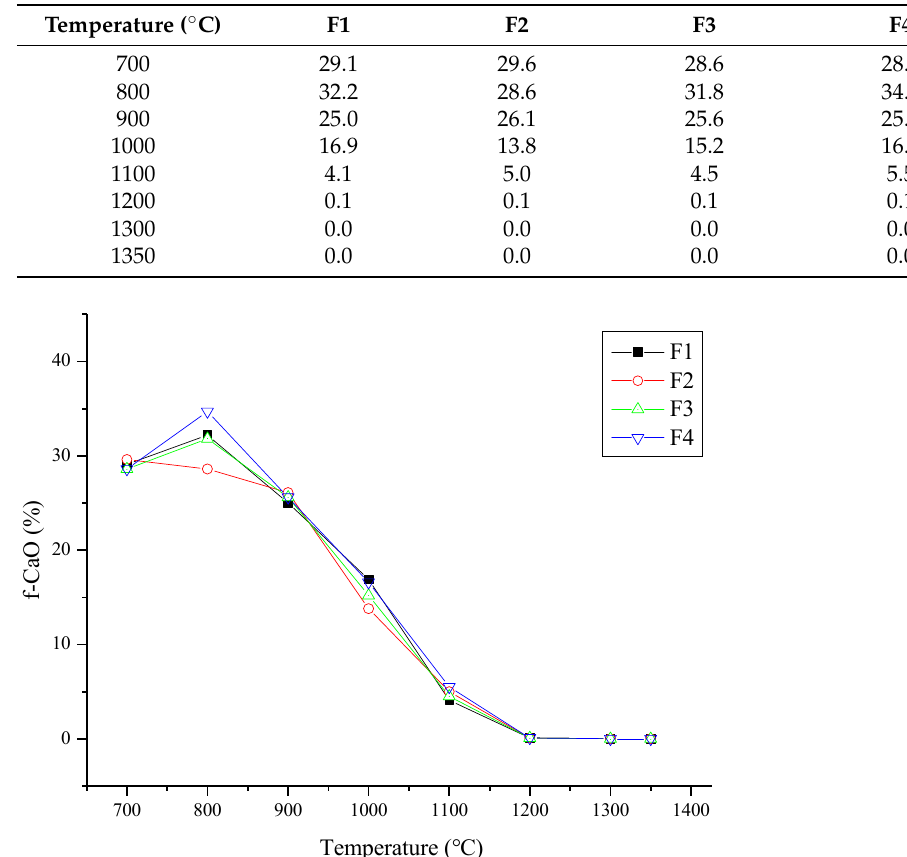
Table 2. f-CaO at different sintering temperatures.